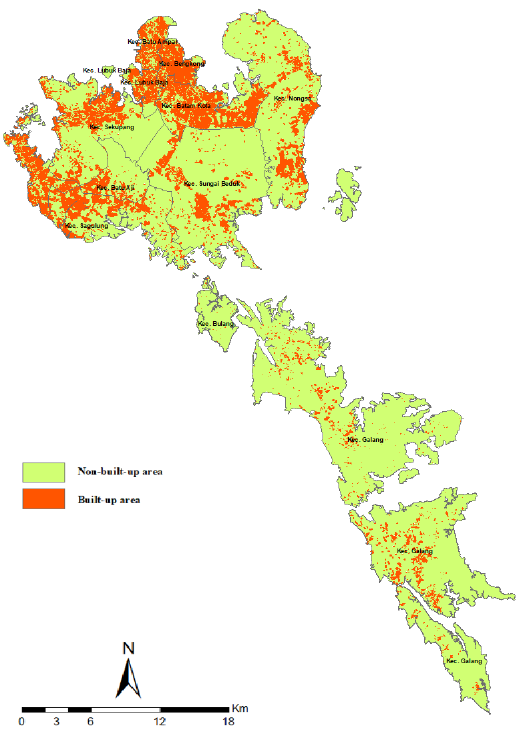
Figure 4. Land cover prediction map in 2035.